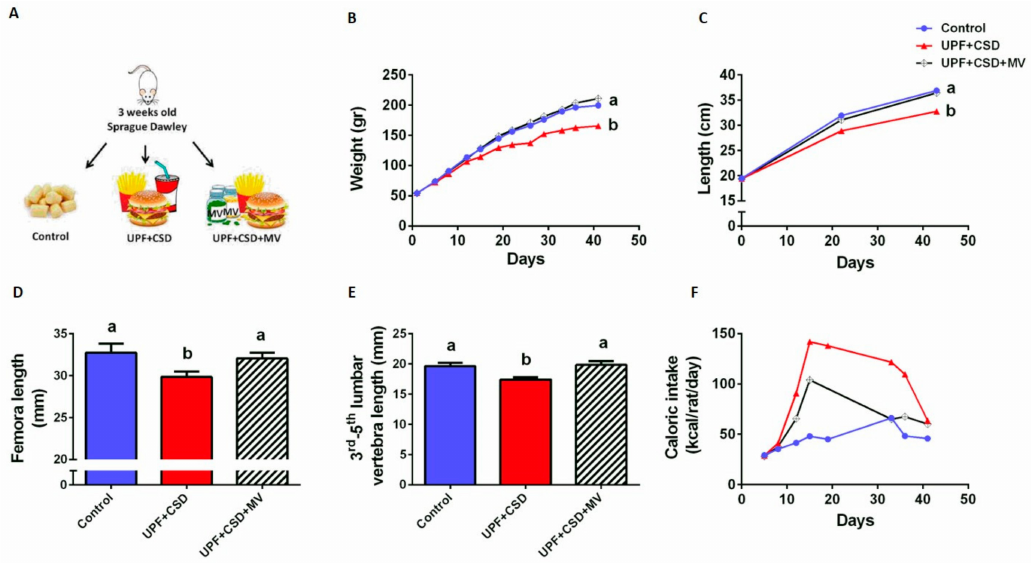
Figure 1. Consumption of ultra-processed food (UPF) leads to growth retardation, which is prevented by supplementation with multi-vitamins and minerals. ( A ) Schematic illustration of the experimen- tal setup. The Control group (n = 8) received a standard diet based on the Harlan Laboratories recommended composition for growing rats; the UPF + CSD group (n = 8) received a diet rich in fat and sucrose, which was composed of a homogenized McDonald’s meal and a soft drink; the UPF + CSD + MV group (n = 8) received a diet rich in fat and sucrose, which was composed of a homogenized McDonald’s meal and a soft drink and was supplemented with multi-vitamins and minerals (n = 8). Throughout the experiments, body weight, body length from the tip of the nose to the end of the tail, and food and fluid consumption were measured twice a week, and daily food intake in kilocalories was calculated for each rat per day. At 9 weeks of age, the rats were anesthetized with isoflurane, blood samples were collected, and they were sacrificed. Their internal organs and bones (femur, tibia, and spine) were harvested. ( B ) Body weight. ( C ) Total length from nose to tail. ( D ) Femora length at 9 weeks of age. ( E ) Third to fifth lumbar vertebra length at 9 weeks of age. ( F ) Daily caloric intake (Kcal/rat/day). Values are expressed as mean ± SD, n = 8. Different letters denote significant difference at p < 0.05 between